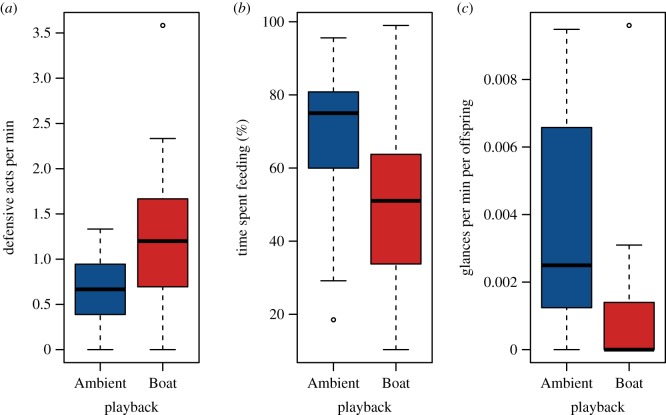
Behavioural responses to playback of motorboat noise compared with playback of ambient sound: (a) brood-guarding males made more defensive acts per min; (b) males spent less time feeding; (c) glancing behaviour was rarer. Boxes represent interquartile ranges and lines within boxes represent the median across 19 Ambient and 17 Boat nests. Whiskers represent ±1.5 × interquartile range. Open circles denote any data points that fall outside of the range of the whiskers. N determined by number of nests, data within nests averaged over duration of exposure, two Boat nests suffered complete mortality prior to first observation. (Online version in colour.)